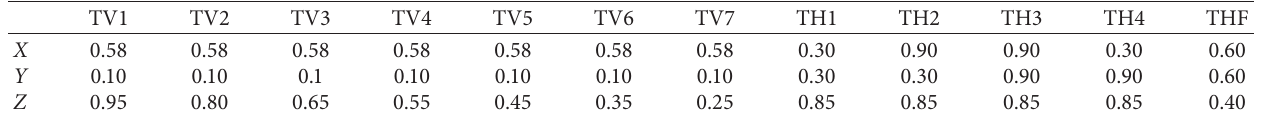
Figure 6: Experimental diagram illustrating the locations of thermocouples in the experimental room. Table 1: Coordinates of the thermocouples installed in the experimental